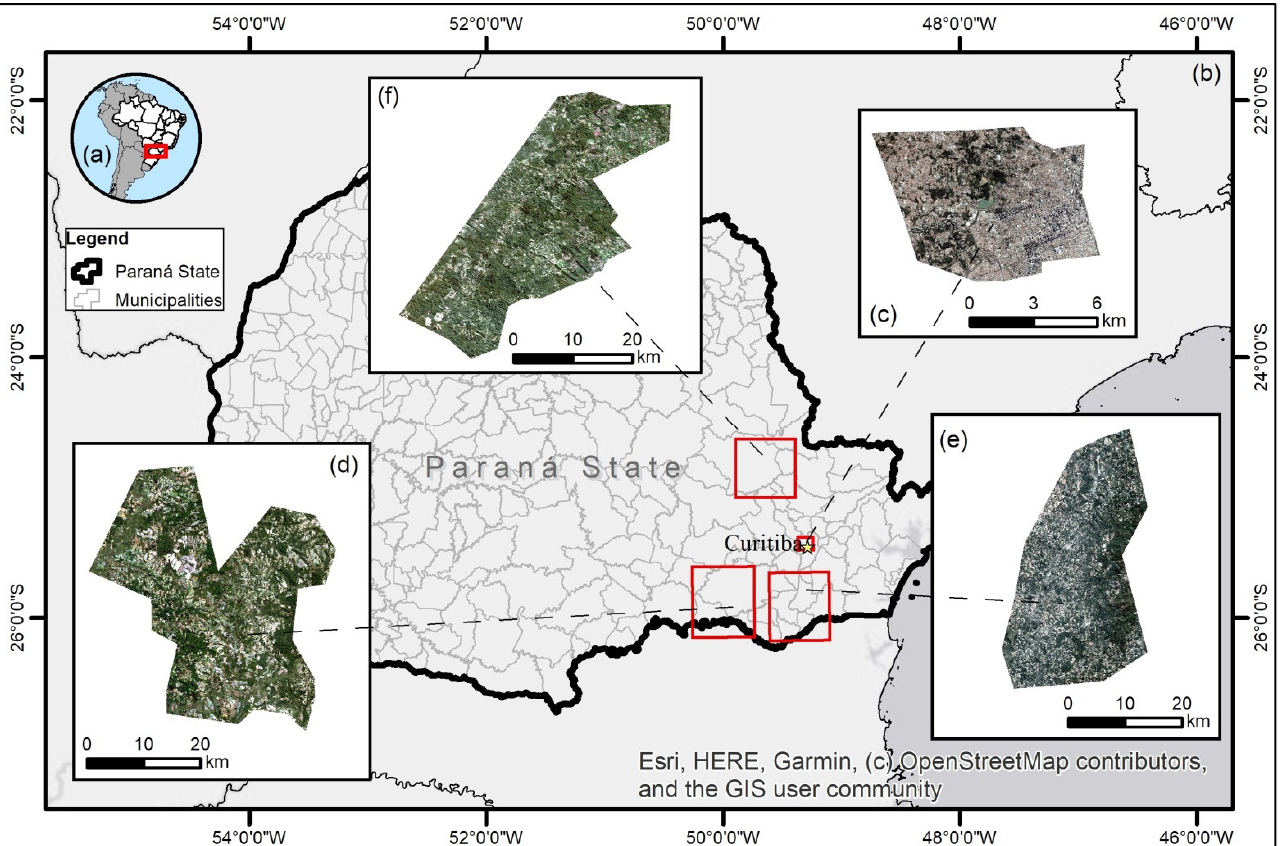
Figure 1. Study area ( a ) Overview of the location in Southern Brazil; ( b ) Site locations in Paraná State; ( c ) Site 1; ( d ) Site 2; ( e ) Site 3; and ( f ) Site 4.